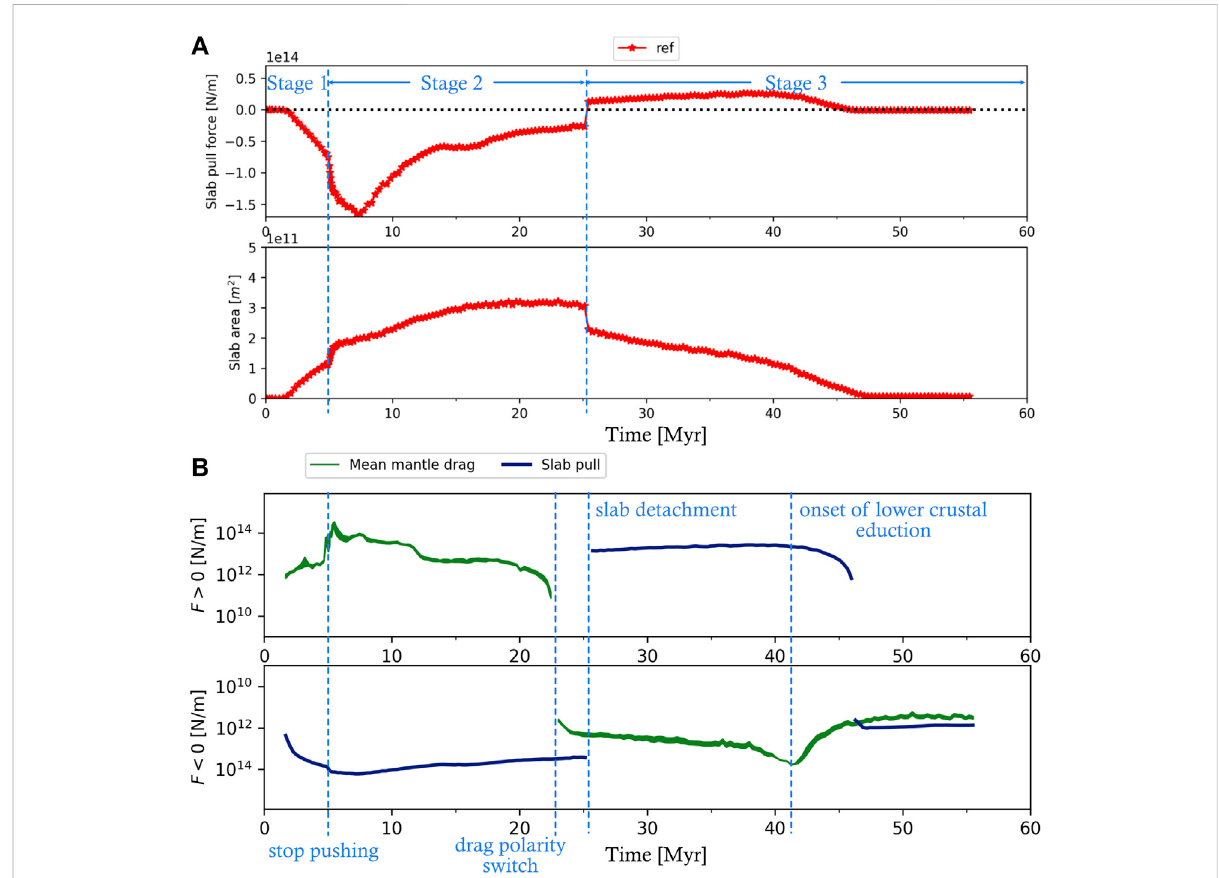
FIGURE 6 Temporalevolutionofthemostimportantforcesinthemodel,calculatedfollowingtheprocedureoutlinedinAppendixA (A) Slabpull(top)and slab area (bottom). Peak slab pull is reached around t = 7.0 Myr, but peak slab area is reached right before slab detachment, which is indicated by a jumpinbothquantities.From45 Myronwards,slabpullisaround10 12 N/m. (B) Evolutionofthemeanmantledragforcebeneaththeoverridingplate. Slab pull is drawn for reference. The top panel displays the positive values, while the bottom panel depicts negative values. Positive values represent trenchward mantle drag and upward slab pull, and vice versa for the negative values. Note the log scale on the y